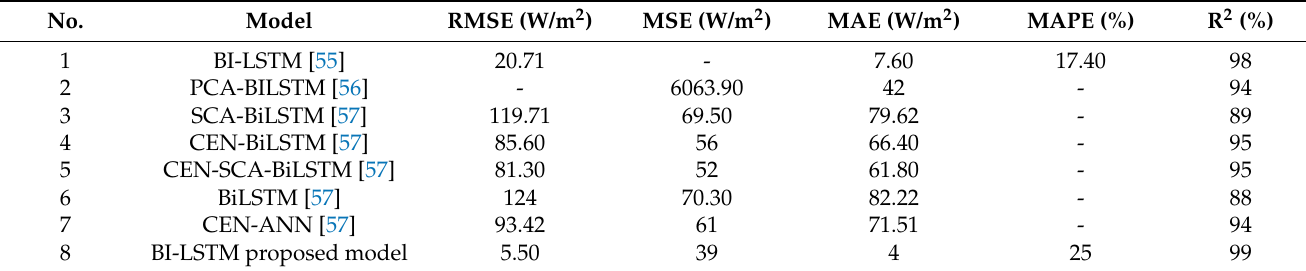
Table 3. Comparison of BI-LSTM proposed model performance with other solar irradiance models. No.